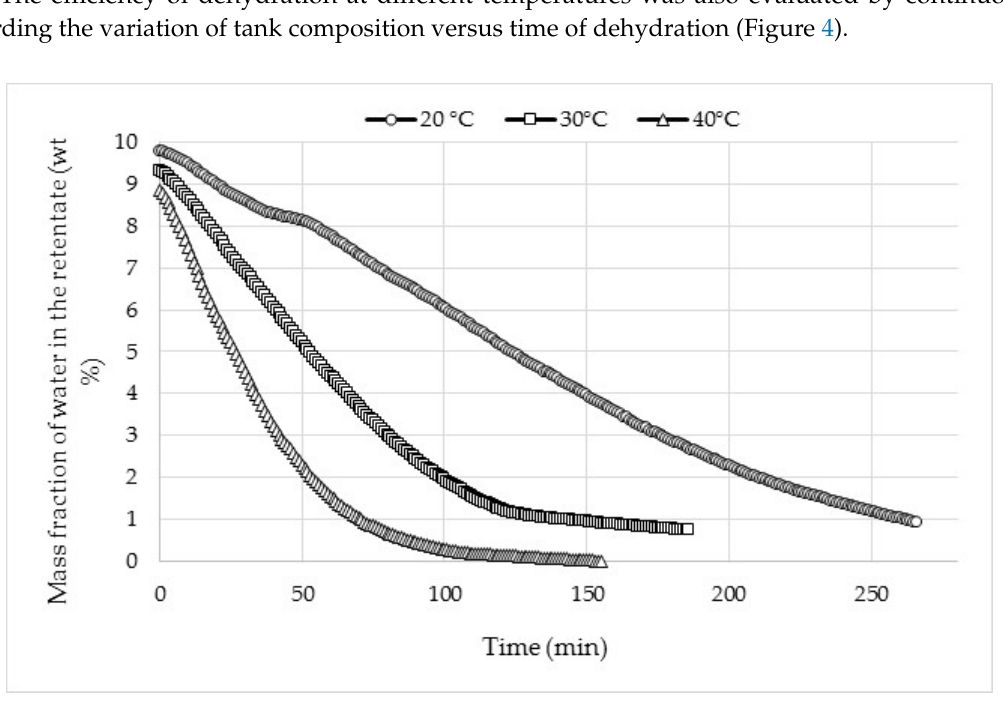
Figure 4. On-line monitoring of water content in the retentate during the acetone dehydration through the HybSi ® membrane depending on operating temperature.